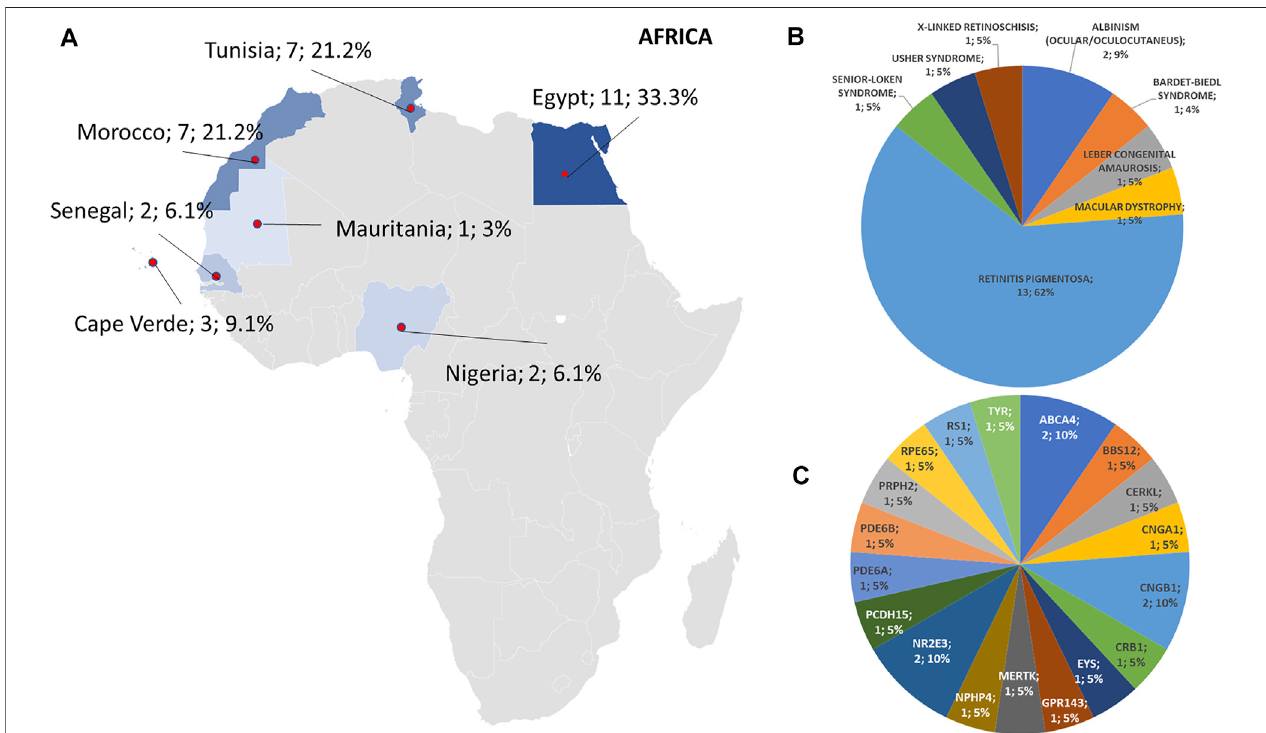
FIGURE 2 | Phenotype and genotype distributions in African countries. (A) The map shows the numbers and percentages of examined patients. Pie charts show the (B) phenotypes and (C) genotypes of positive cases.